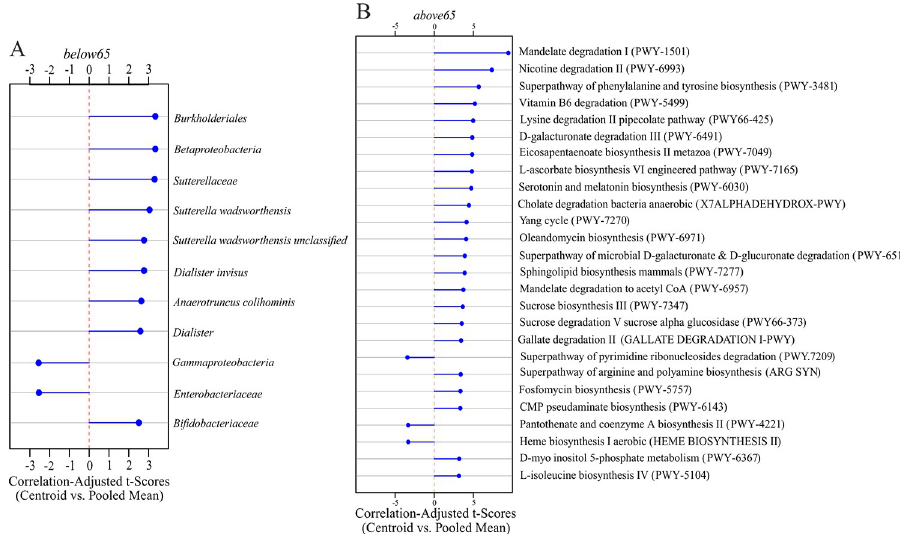
Fig 5. Top 11 bacteria and top 26 pathways according to CAT-scores. The (A) top ranked 11 bacteria and (B) top ranked 26 pathways according to CAT-scores. The length and direction of the blue bars indicate the influence of a given biomarker on the discriminative power of the model. A: The order Burkholderiales within the class Betaproteobacteria have the highest potential for separation of the age groups with a positive CAT-score indicating an over-representation in the below65 group. While both, the family Enterobacteriaceae within the class Gammaproteobacteria have a negative CAT-score indicating an over-representation in the above65 group. B: Most of the pathways shown have a higher relative abundance in the elderly population with mandelate degradation (PWY- 1501) contributing most to group separation. above65 : patients aged 65 years and above (n = 145), below65 : patients below 65 years of age (n = 133). CAT-scores, correlation adjusted T-scores.